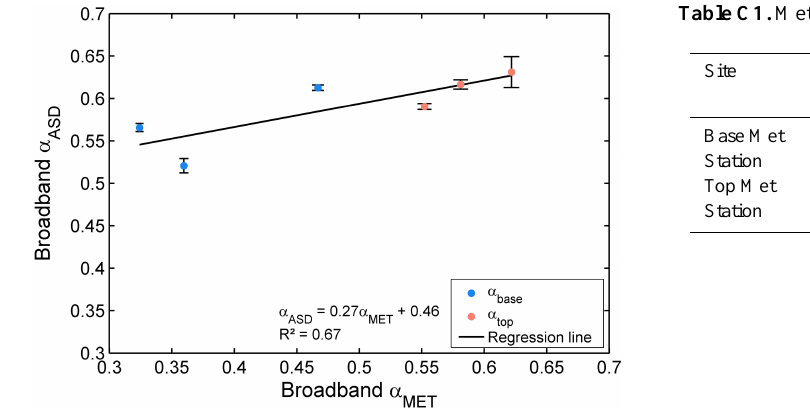
Figure B3. Broadband α base (blue dots) and α top (pink dots) vs. α ASD and α MET (i.e., both α base and α top ) measurements fit- ted to a linear regression equation ( R 2 = 0 . 67). The value of α ASD error is based on the standard deviation of individual α ASD mea- surements.